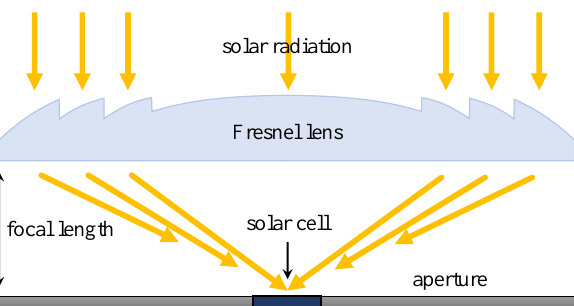
Figure 4. Fresnel lens concentrator focusing the light into one point without SOE [50].